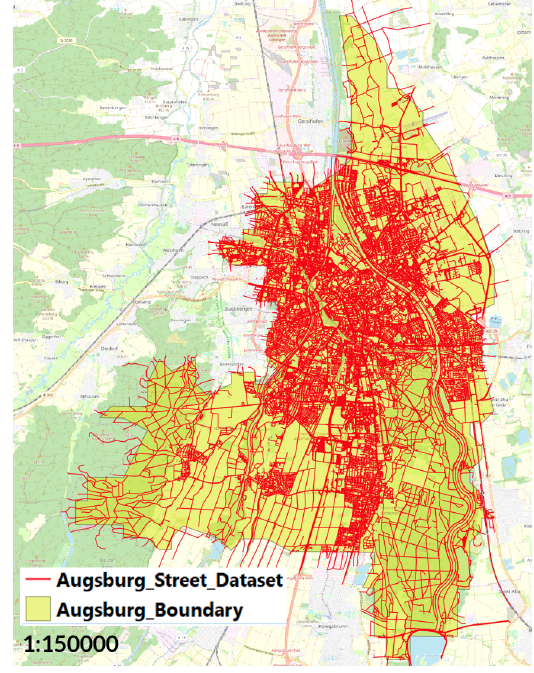
Figure 1. The overview of the input street network dataset in the area of Augsburg displayed on the QGIS